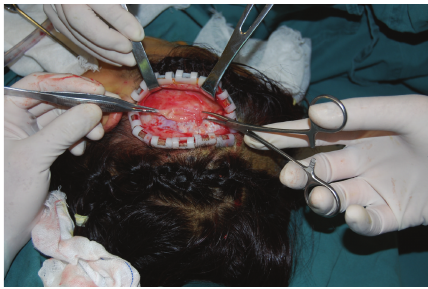
Figure 3: Photograph from the surgery showing the thickened epicranial aponeurosis containing